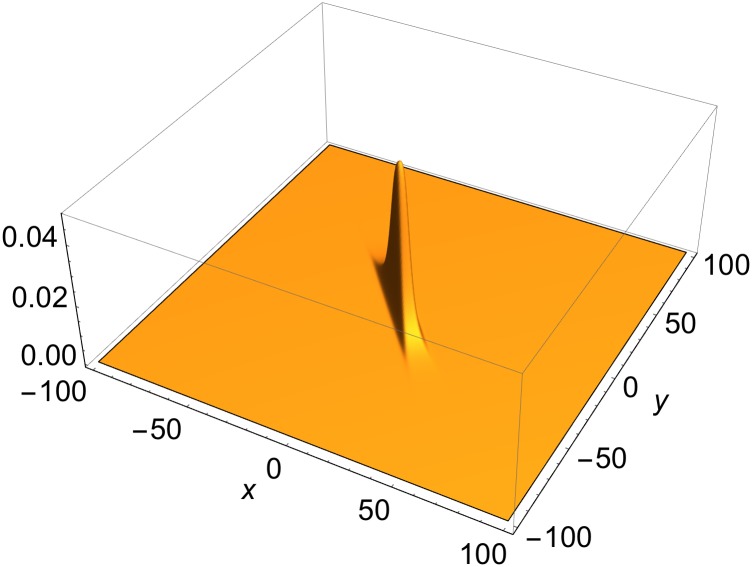
Lateral profile of single-rod solution of Eq (3) in rest frame.p(1) = {0, cosφ(1), sinφ(1), 0}, p(2) = {0, cosφ(2), sinφ(2), 0}; φ(1) = π/5, φ(2) = π/4; δ(1) = δ(2) = 0.